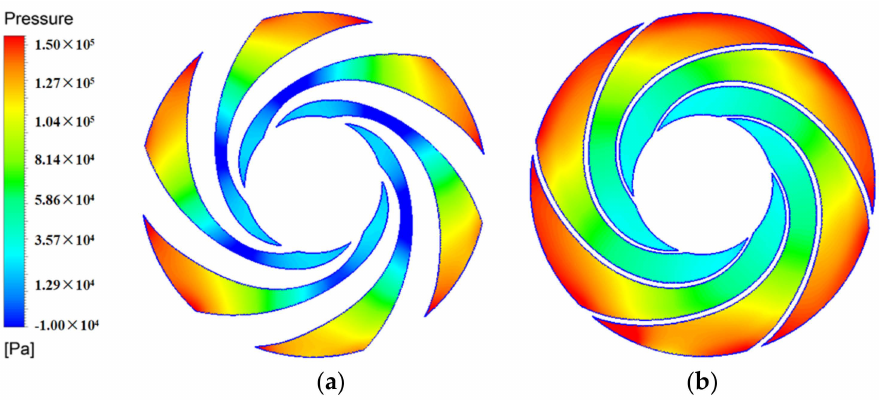
Figure 15. Impeller meridian plane of 6-blades pump of ( a ) scheme 20 and ( b ) scheme 7.